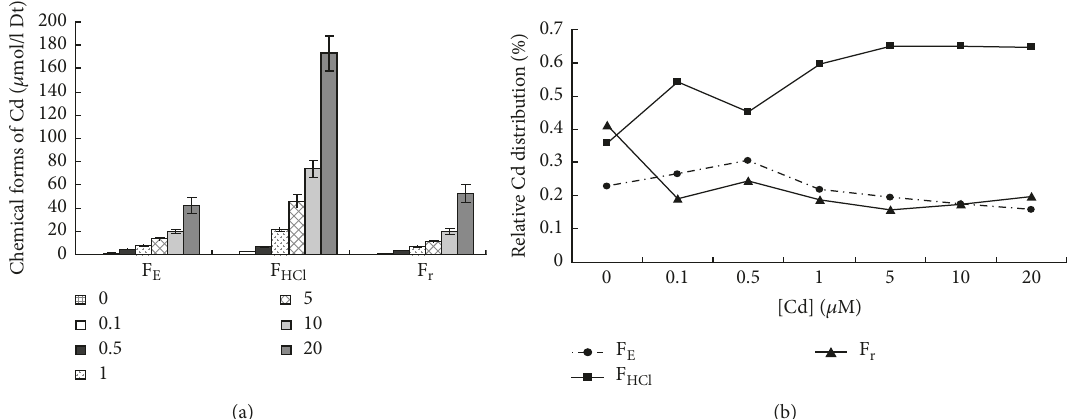
Figure 3: Chemical forms of Cd in duckweed roots (a) and percentage (b) after a 4-day period of exposure to Cd stress.